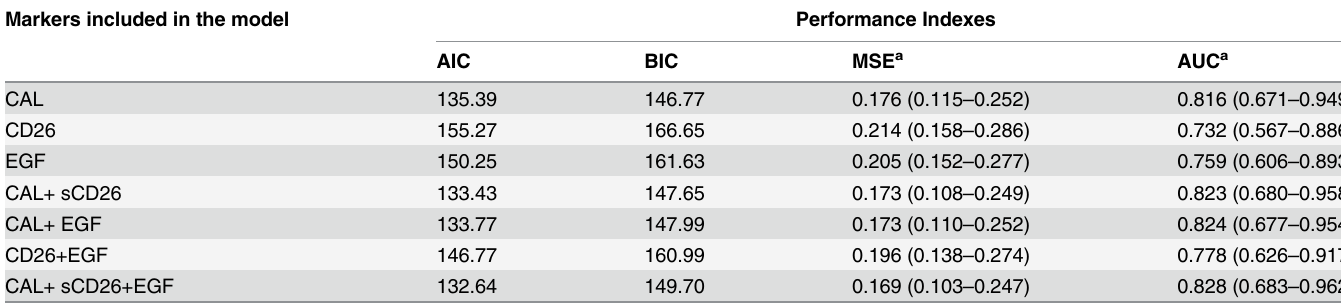
Table 5. Performance of each model